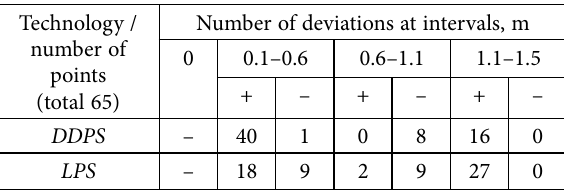
Table 2. Results of the investigation on the accuracy of point coordinates compared with stereoscopic measurements Measurement